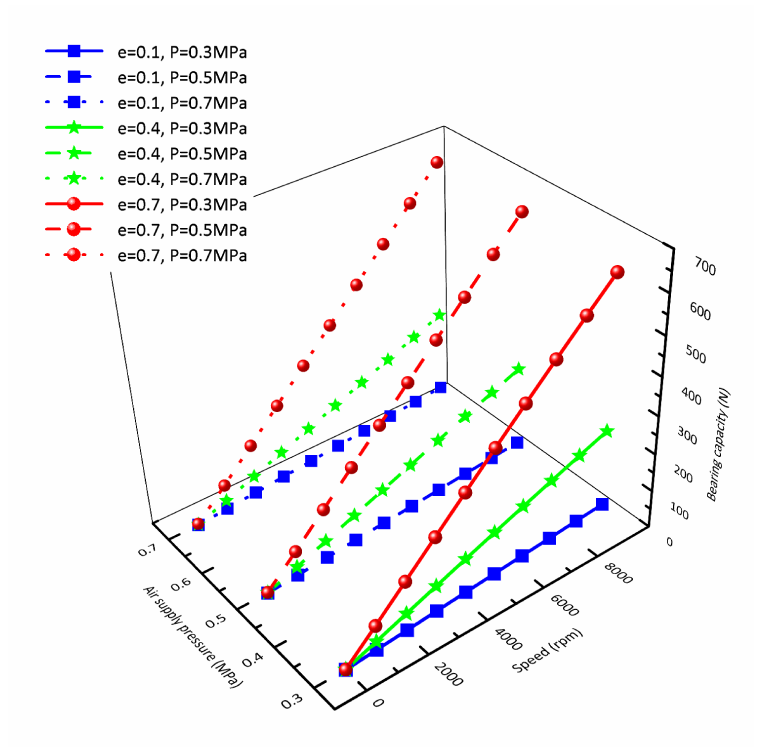
Figure 7. Influence of rotating speed on bearing